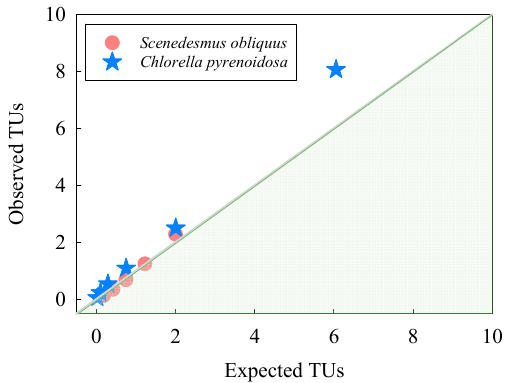
Figure 4. Observed toxic units (TUs) as converted from the toxicity data of Scenedesmus obliquus and Chlorella pyrenoidosa following exposure to mixtures of TiO 2 NPs and NTs, and subsequently plotted against expected TUs calculated on the basis of the median effect concentrations from the individual constituents present in the mixtures.